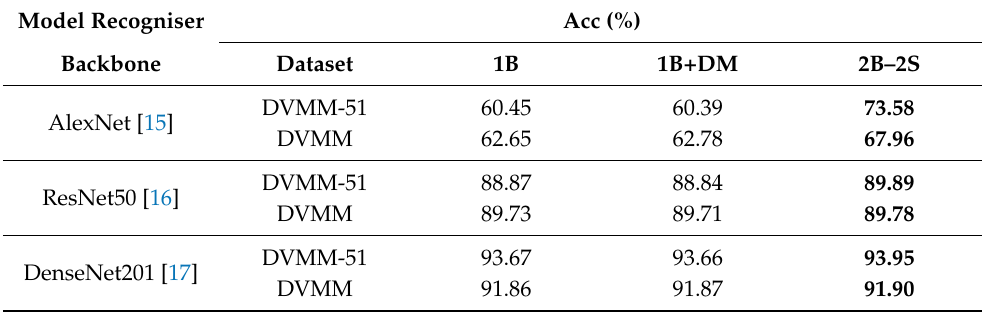
Table 12. Ablation study over DVMM and